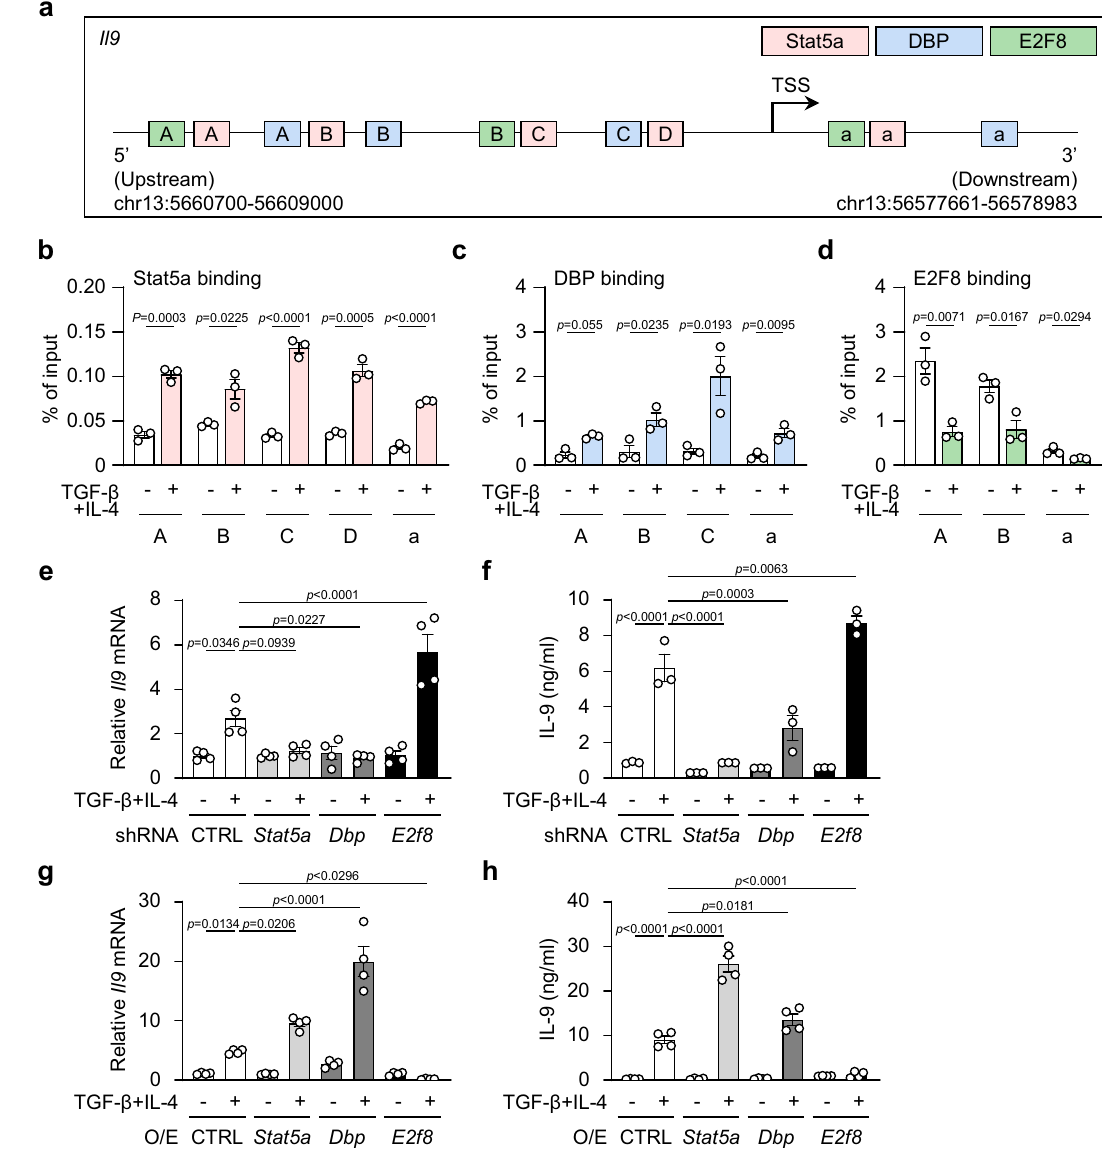
Fig. 4 | Increased DBP but decreased E2F8 binding at Il9 gene during Th9 differentiation.a Identi fi cationofStat5a,DBPandE2F8bindingelementsinthe Il9 gene. b – d ChIP assayanalysisfor binding ofStat5a, DBP and E2F8 to the promoter region of the Il9 during Th9 differentiation. e , g Expression of Il9 mRNA and f , h ELISA of IL-9 and in CD4 + T cells transfected with Stat5a , Dbp or E2f8 speci fi